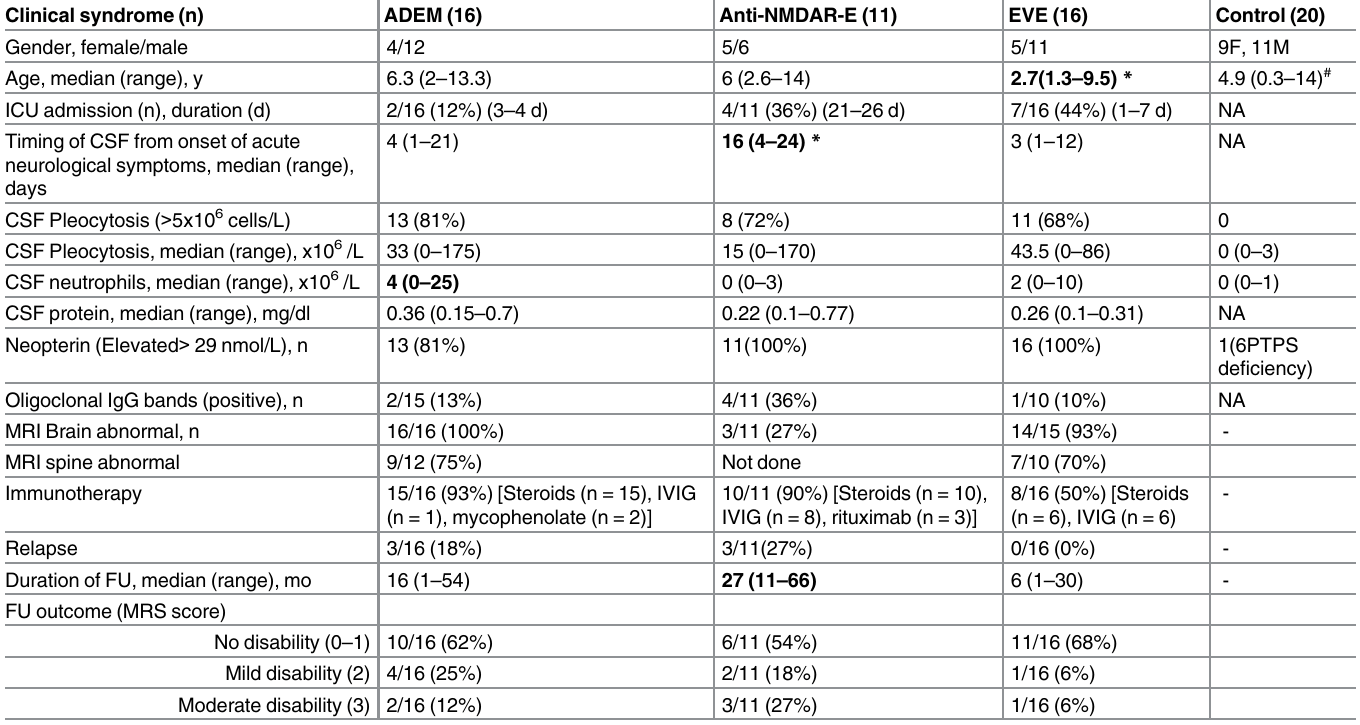
* Highlighted results represent variables with P < 0.05 in the Kruskal Wallis test, see results section for more details # age at the time of CSF sampling Abbreviations: ADEM, acute disseminated encephalomyelitis; Anti-NMDAR E, anti-N-Methyl D-Aspartate receptor encephalitis; EVE, entero